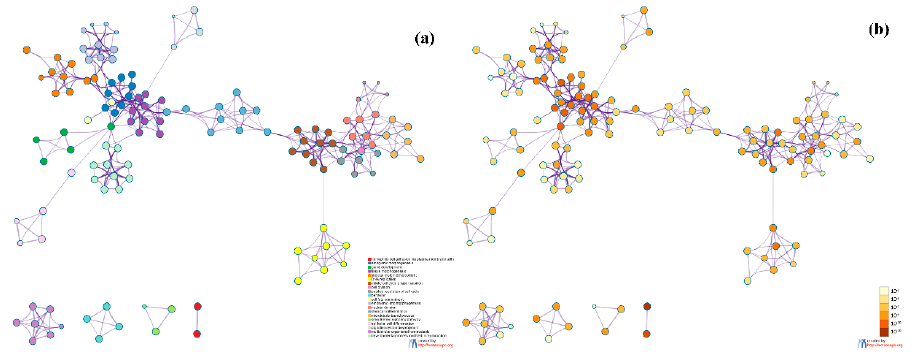
Figure 13. Network of enriched terms on biological processes: ( a ) colored by cluster ID, where nodes that share the same cluster ID are typically close to each other; ( b ) colored by p -value, where terms containing more genes tend to have a more significant p -value.